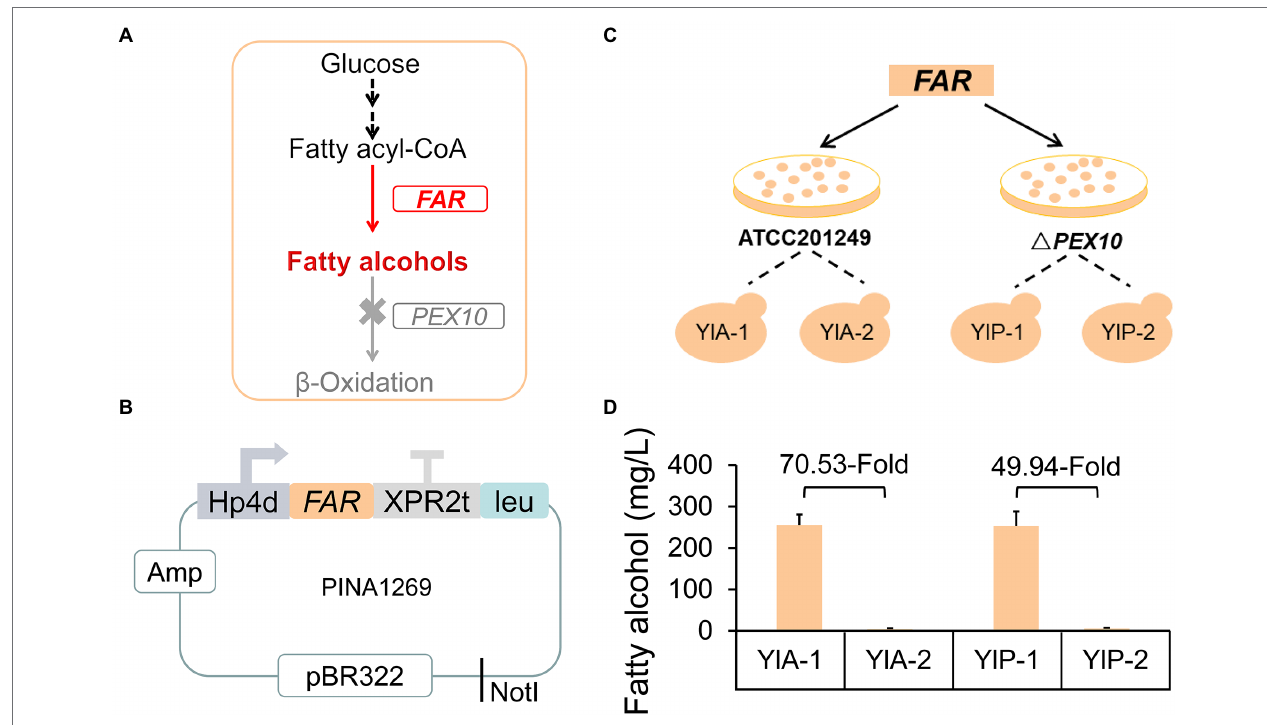
FIGURE 1 | Strains with different fatty alcohols yields were found in the same batch of transformed of FAR gene. (A) Schematic diagram of the fatty alcohol biosynthesis pathway engineering strategies in Yarrowia lipolytica . FAR , fatty acyl-CoA reductase gene from Marinobacter aquaeolei VT8; PEX10 , the peroxisome synthesis gene. Fatty acyl-CoA reductase converts fatty acyl-CoA to fatty alcohols. The gene PEX10 was deleted to prevent the degradation of fatty alcohols. (B) Schematic diagram of the plasmid pINA1269- FAR used to transform Y. lipolytica . The FAR gene was driven by the Hp4d promoter and the plasmid was linearized by NotI and transformed into different basic strains and two transformants were randomly selected from each plate for fermentation (C) . (C) Schematic diagram of establishing exogenous synthesis pathway of fatty alcohols. (D) Fatty alcohols production of strains from the same batch of transformants. All strains